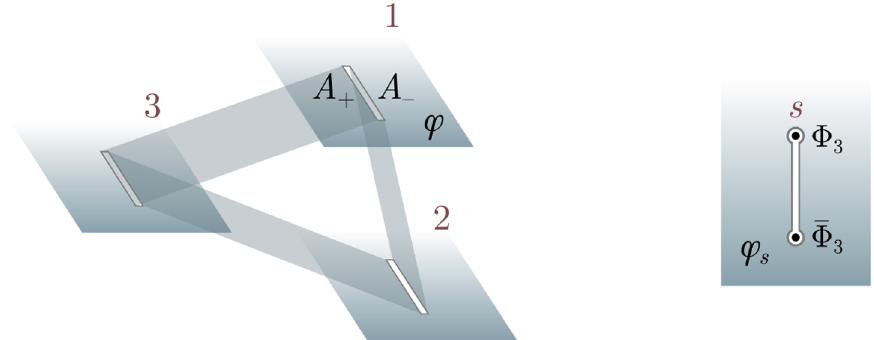
Figure 6 . Left . Three-replica geometry, R 3 , with a local field ϕ . Right . Individual copies s , with boundary conditions for ϕ i implemented by twists Φ 3 , ¯Φ 3